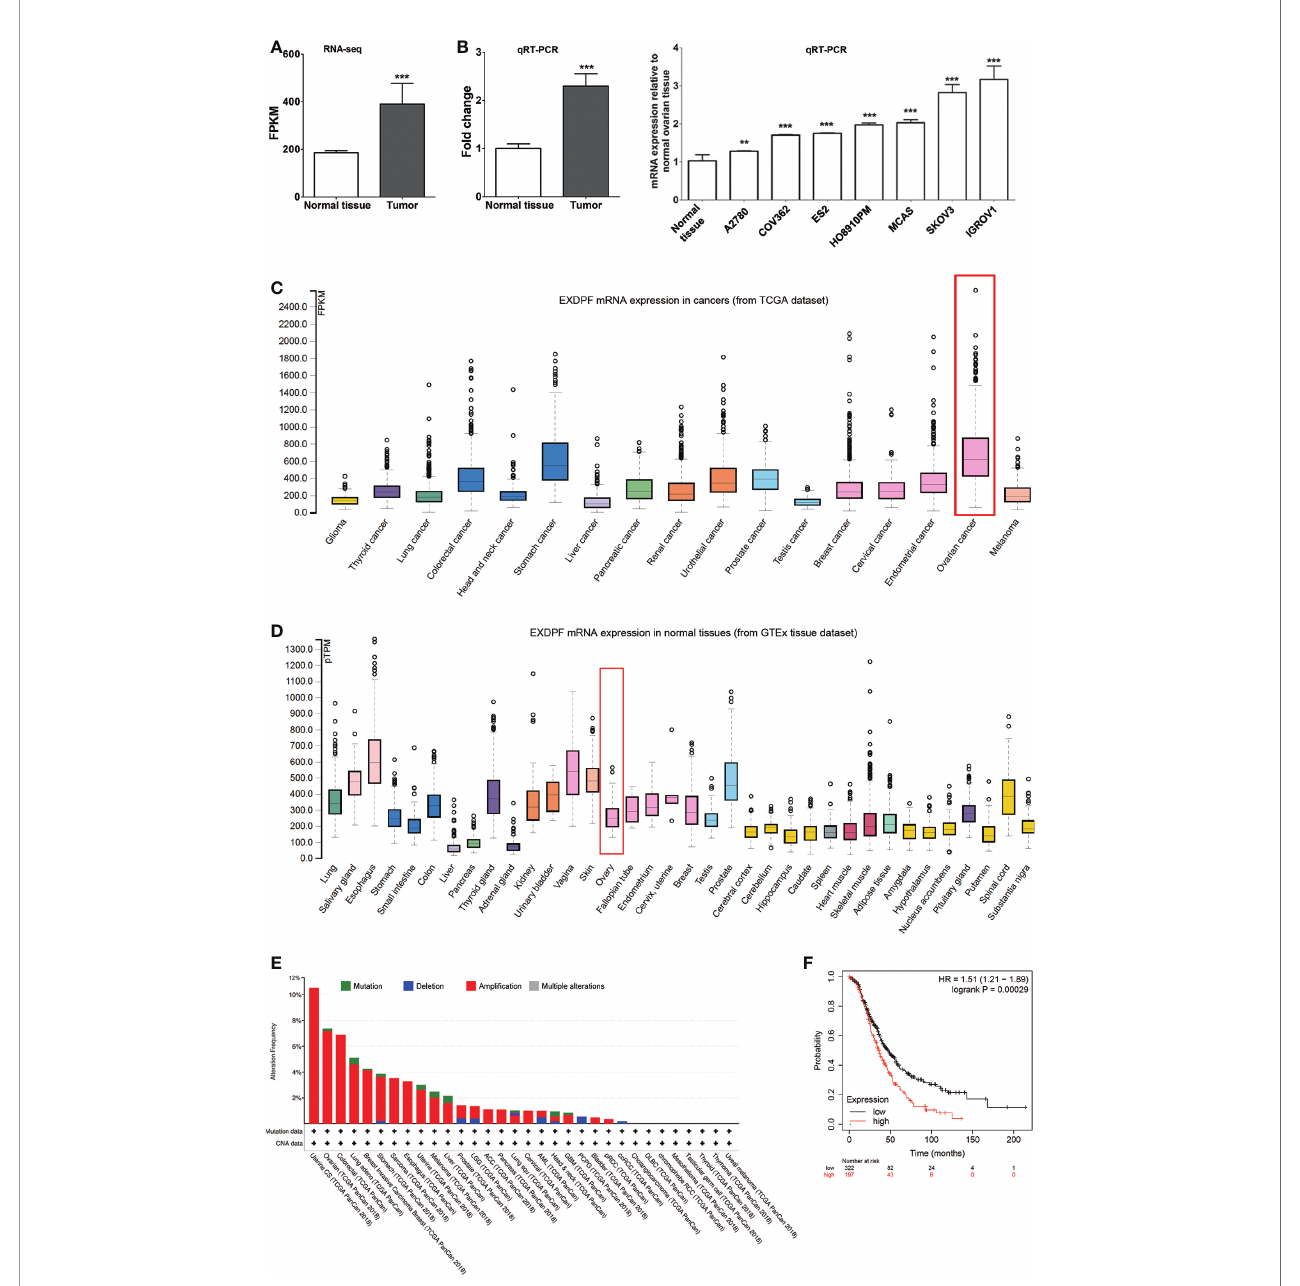
FIGURE 1 | EXDPF over-expressed in ovarian tumors which correlated positively with poor OS of patients. (A) Total mRNA from three pairs of samples, both epithelial ovarian tumors and ovarian normal tissue controls from the same patients, were used for RNA sequencing. EXDPF mRNA expression levels were presented as fragments per kilobase of transcript per million mapped reads (FPKM). Statistical analysis was tested between ovarian tumors and normal tissues. (B) Eight pairs including the 3 pairs used for RNA sequencing of ovarian tumors and normal ovarian tissue controls were used for total RNA extraction followed by qRT-PCR assay. EXDPF expression levels were present as the ratio of Ct values of EXDPF to that of GAPDH. EXDPF expression levels of normal tissues were normalized to 1.0. Statistical analysis was tested between ovarian tumors and the normal tissue controls. (C) Total mRNA was extracted from seven epithelial ovarian cancer cell lines (SKOV3, IGROV1, MACS, HO8910PM, ES2, COV362 and A2780) and normal ovarian tissues as in panel (B) and detected by qRT-PCR assay as above. Statistical analysis was performed between ovarian cancer cell lines and the normal tissue controls. (D) EXDPF mRNA expression levels in ovarian tumors (upper panel) and normal ovarian tissues (lower panel) indexed from TCGA and GTEx database, respectively, were compared using The Human Protein Atlas online dataset. Rectangle marks ovarian cancer or normal ovarian tissue data. (E) cBioPortal online database was used to detect the DNA Copy Number Alteration (CNA) of EXDPF in 32 different human tumors. Data were indexed from TCGA database. Ovarian cancer had the second highest DNA ampli fi cation of EXDPF among these cancers tested. Red bar represents DNA ampli fi cation and green bar represents DNA mutation. (F) Kaplan Meier-Plotter online database was used to analyze the relationship between EXDPF mRNA expression levels and ovarian cancer patient overall survival (OS). Red line shows the samples with higher EXDPF expression levels while black line with lower EXDPF expression levels. Data are presented as mean ± SD. ** p < 0.01; *** p <